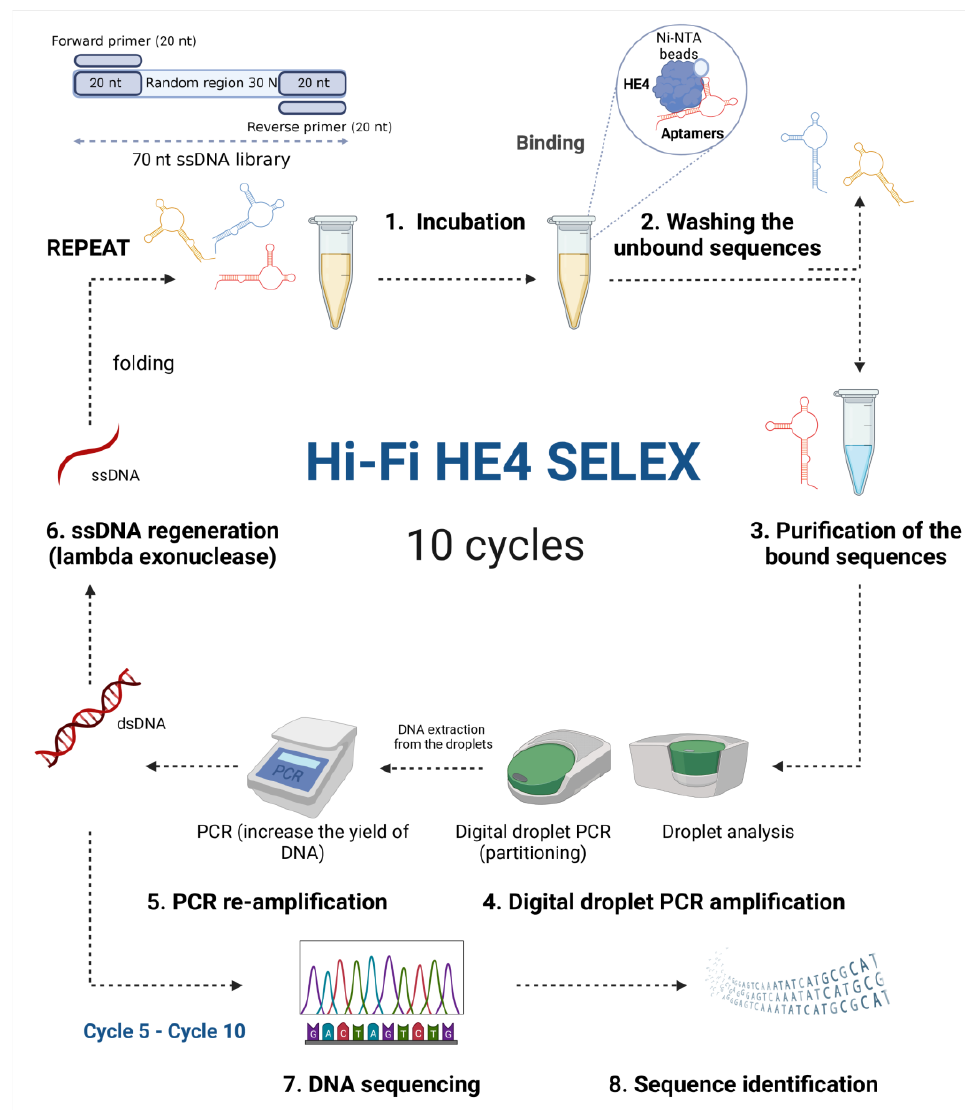
Figure 1. Schematic representation of the digital droplet PCR (ddPCR)-based High Fidelity Systematic Evolution of Ligands by EXponential enrichment (Hi-Fi SELEX) method for the selection of aptamers to ovarian cancer biomarker Human epididymis protein 4 in urine. High-affinity aptamers are selected from initial 70 nucleotide long (70 nt) single-stranded DNA library consisting of random 30 nucleotide long region (30 N), flanked by 20 nucleotide long (20 nt) constant regions used for PCR amplification. Briefly, the aptamer libraries are incubated with target HE4 protein in urine. Non- specific unbound sequences are washed, while specific bound sequences are recovered and